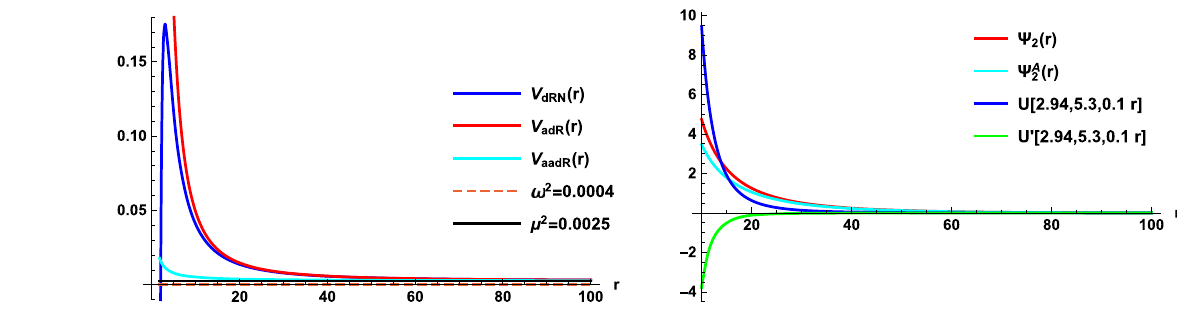
0 . 45 ) to meet a superradiant stability with V (cid:15) region scalar function (cid:17) 2 ( r ) and its asymptotic form (cid:17) A fluent hypergeometric U [ 2 . 94 , 5 . 3 , 0 . 1 r ] represent bound states